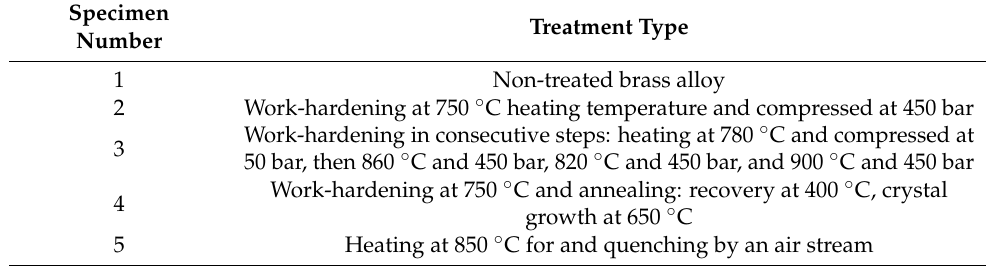
Table 1. Treatments of